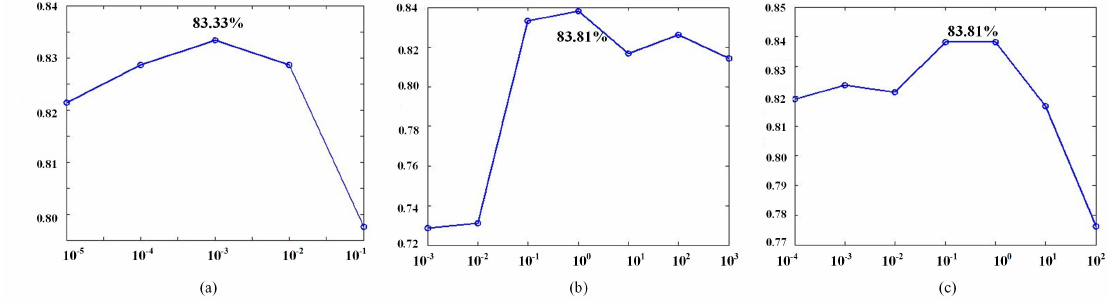
Figure 8. Evaluation of the effect on the classification accuracy for parameters: ( a ) λ ; ( b ) η ; and ( c ) ρ